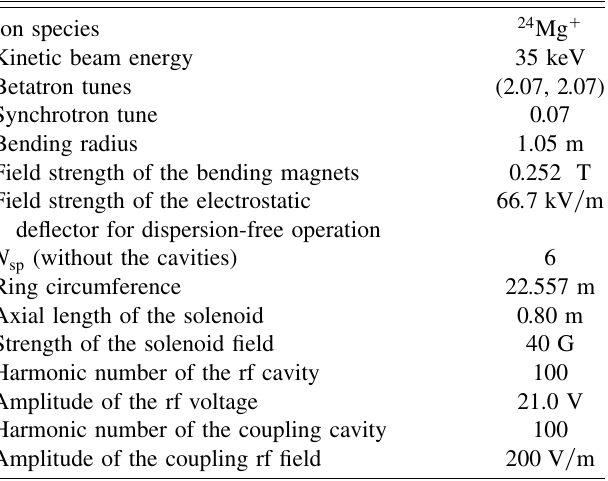
(cid:4) (cid:2) (cid:3) 2 : 07 ; 2 : 07 ; 0 : 22 (cid:4) . The ; (cid:6) ; (cid:6) x y z